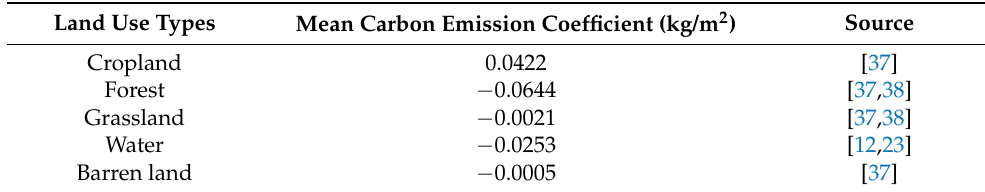
Table 2. Carbon emissions coefficients of each land use type and their